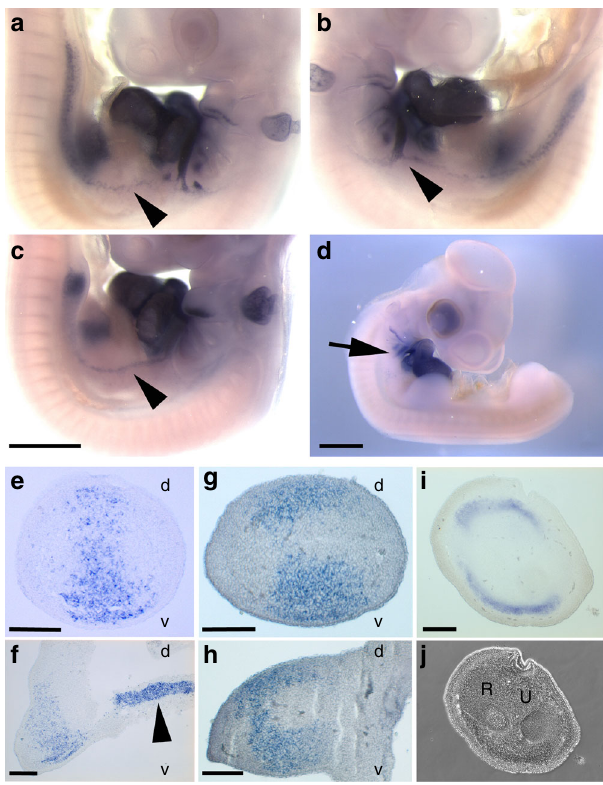
Fig. 3 Details of Nkx2.5 expression in the developing emu wing and surrounding tissue. a HH21 emu, left side, b HH21 emu, right side, c HH22 emu, left side d HH22 chick, right side. Note the line of Nkx2 .5 expression extending from the 6th branchial artery and forming a continuous line of expression with the early forelimb bud ( arrowhead in a – c ). Nkx2.5 expression is apparent in the 6th branchial artery of HH22 chick but does not extend distally to the limb bud ( arrow in d ). e – j Sections of emu embryos whole-mount in situ hybridization stained for Nkx2.5 . e Transverse section and f longitudinal section of HH22 emu forelimb bud. Note the staining corresponding to the domain of expression highlighted in ( a – c ; arrowhead ). g Transverse section and h longitudinal section of HH25 emu forelimb bud. i Transverse section of HH30 emu embryo and j corresponding phase image. Images are representative of two or more embryos at each stage. d, dorsal; v, ventral; R, radius; U, ulna. Scale bar = 1 mm ( c , d ), 200 μ